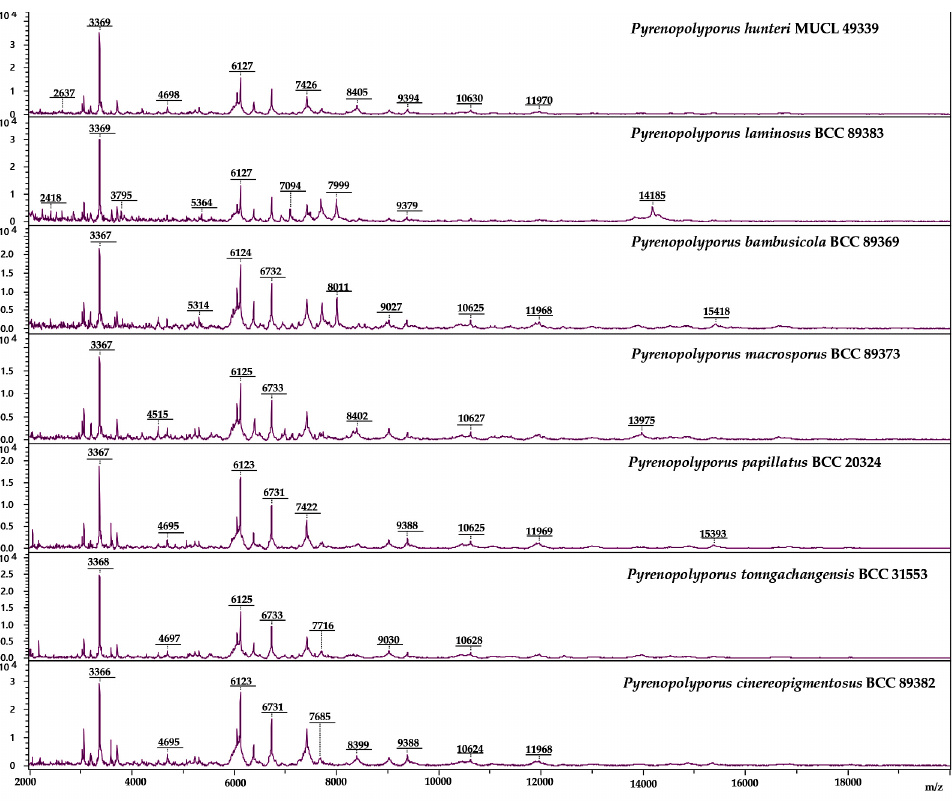
Figure 15. Schematic representation of MALDI-TOF chromatograms from mycelial peptide extracts of Pyrenopolyporus spp. evaluated in this study. All spectra shown are baseline-subtracted, smoothed and with the y-axis auto-scaled covering the mass range from 2 kDa to 20 kDa (with x-axis scale increments of 2 kDa).